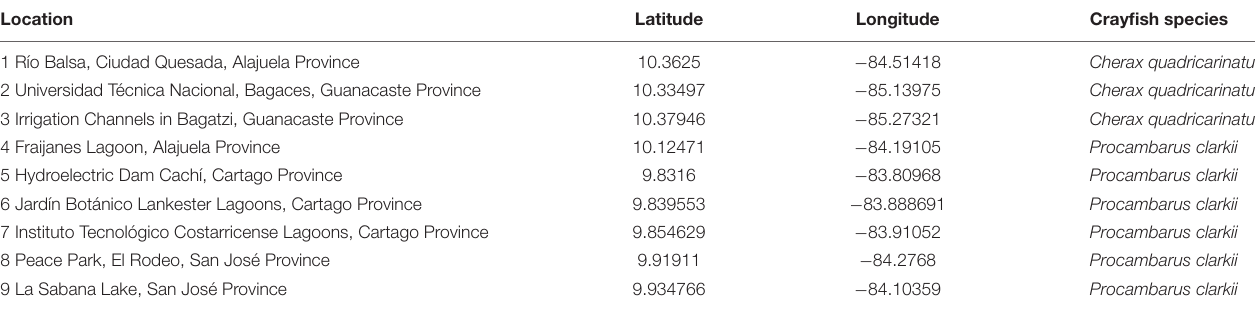
TABLE 1 | Locations of populations of invasive alien crayfish species in Costa Rica.